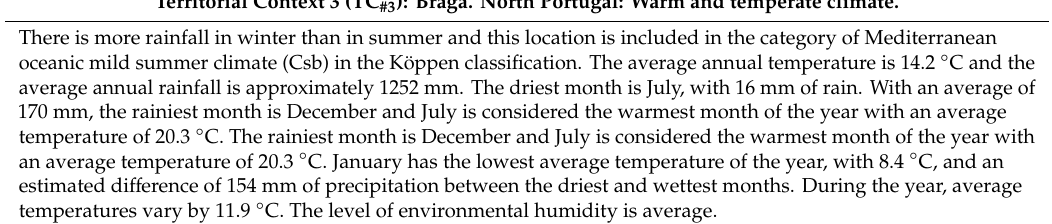
Table 3. Description of Territorial Context